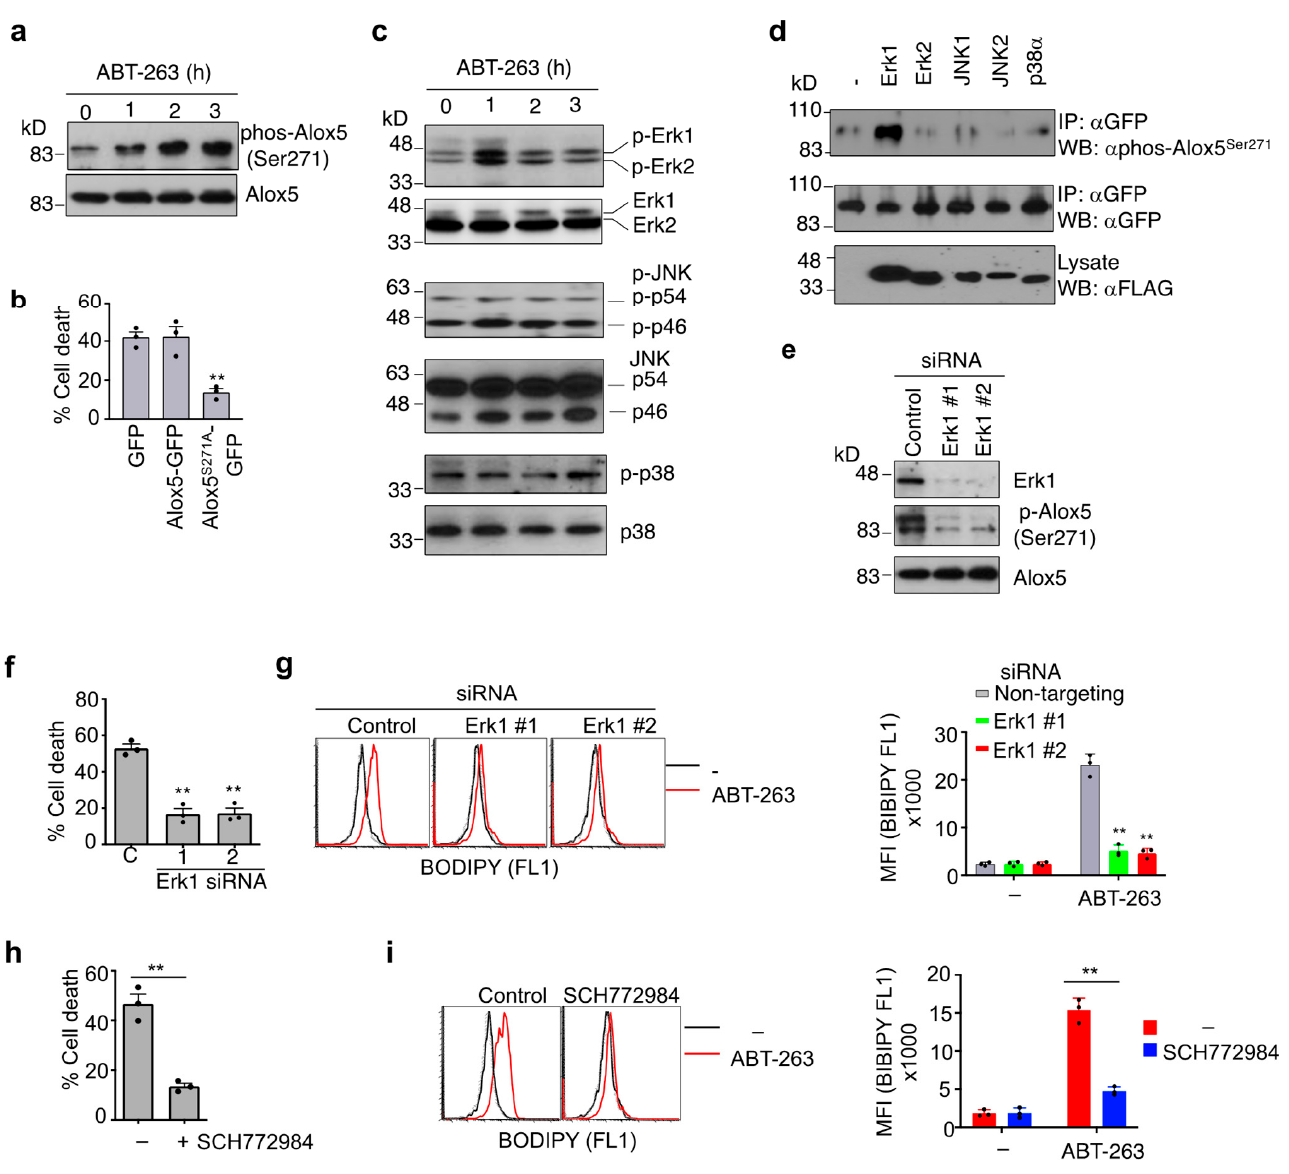
Figure 6. Regulation of Alox5 phosphorylation by Erk1. ( a ) JMR cells treated with ABT-263 for 0, 1, 2 and 3 h were lysed for Western blot analyses of endogenous Alox5 phosphorylation (p-Alox5) at Serine 271. ( b ) JMR cells transfected with plasmids expressing Alox5-GFP, Alox5 S271A -GFP or GFP only were treated with ABT-263 for 24 h. The loss of live GFP + cells was quantitated 24 h later. Data are presented as mean ± SD. Comparison to GFP control: ** p < 0.01. ( c ) JMR cells treated as in (A) were lysed for Western blot analyses of MAPKs. ( d ) Alox5-GFP was co-transfected with FLAG-tagged MAPKs into 293T cells. Cells were lysed 24 h later for immunoprecipitation with anti-GFP, followed by Western blot to detect phospho-Alox5 ser271 . ( e ) JMR cells transfected with siRNA targeting Erk1 were cultured in the presence of ABT-263 for 2 h, followed by Western blot to detect phosphorylation of Alox5 at Serine 271, or total Alox5 and ERK1. ( f , g ) Cells transfected with siRNA as in ( e ) were ( f ) cultured with ABT-263 for 24 h to analyze cell death or ( g ) stained with BODIPY 581/591 C11. Percentages of cell death and MFI of BODIPY 581/591 C11 staining are presented as mean ± SD. Comparison to the control siRNA group: ** p < 0.01. ( h , i ) JMR cells were treated with ABT-263 in the presence or absence of 5 µ M SCH772984, followed by ( h ) analyses of cell death or ( i ) staining with BODIPY 581/591 C11. ** p <